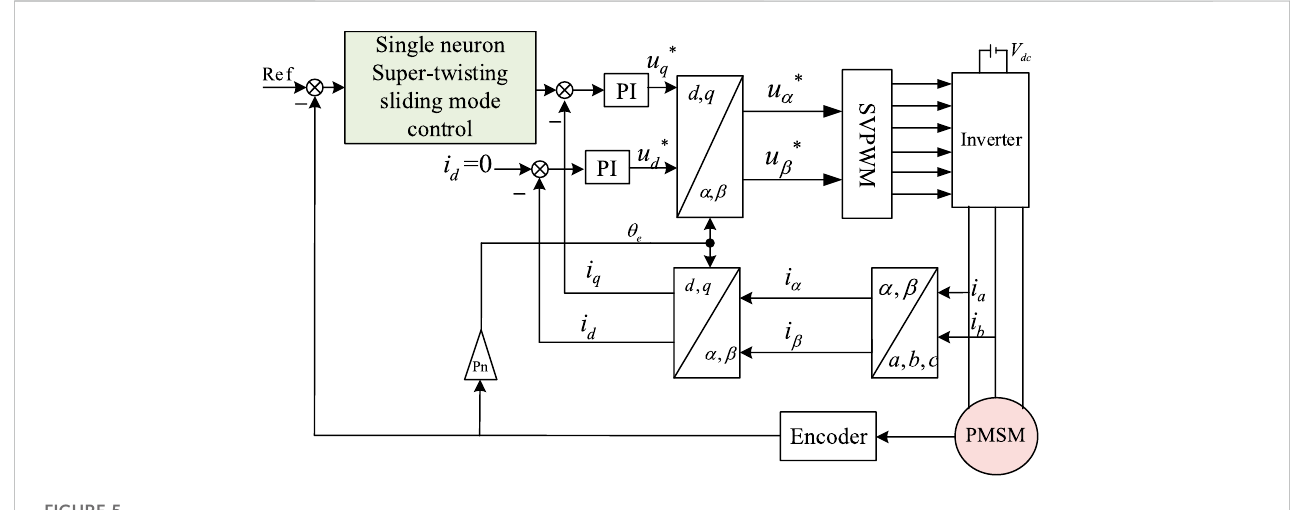
FIGURE 5 Control block diagram for single neuron super-twisting sliding mode control for PMSM